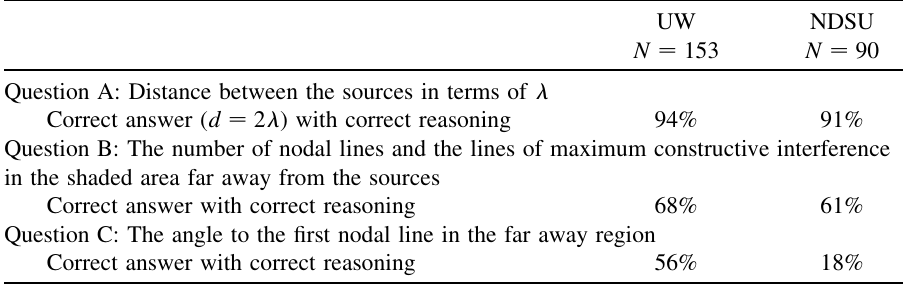
TABLE I. Summary of results from questions A–C of the two-source interference problem after all instruction on two-source interference.